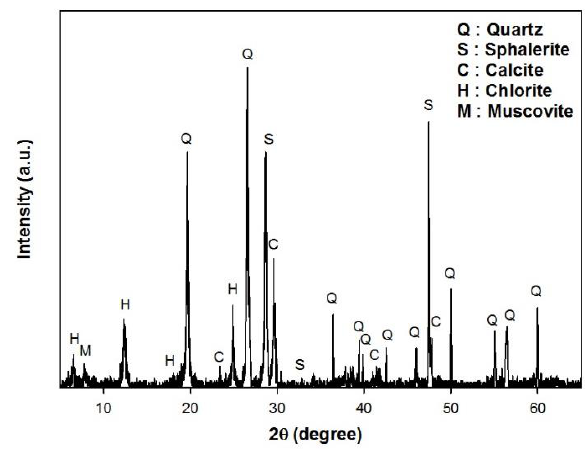
Figure 2. X-ray diffraction (XRD) pattern of the feed sample. Table 1. Yield (wt %) and concentration (wt %) of the target elements in the feed sample as a function of size fractions.